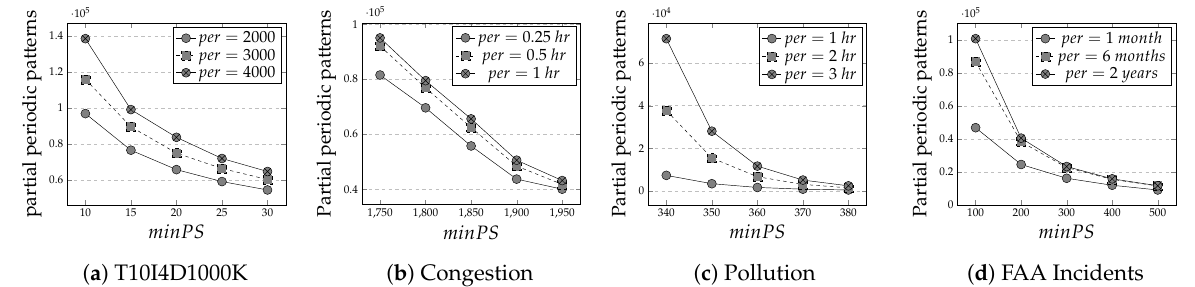
Figure 5. Number of partial periodic patterns that were generated in the various databases ( a – d ) for different minPS and per values.